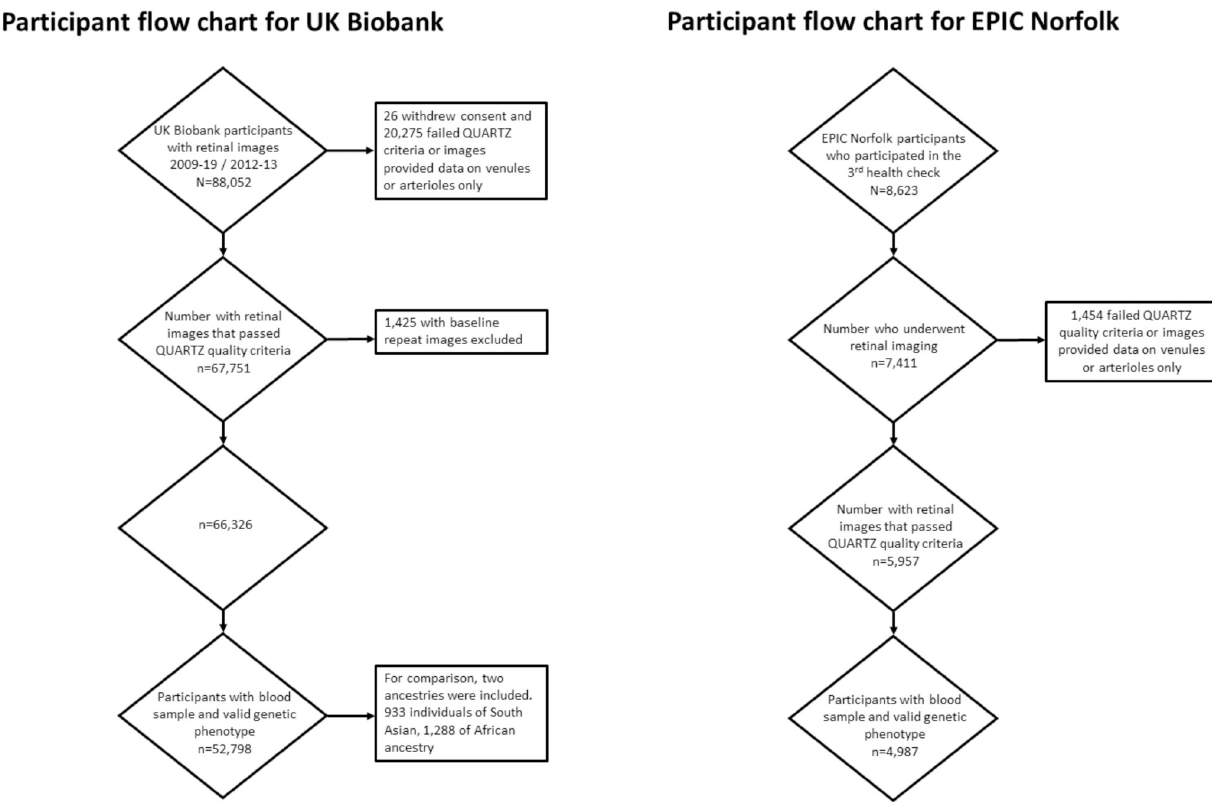
Fig 1. Particpant flow